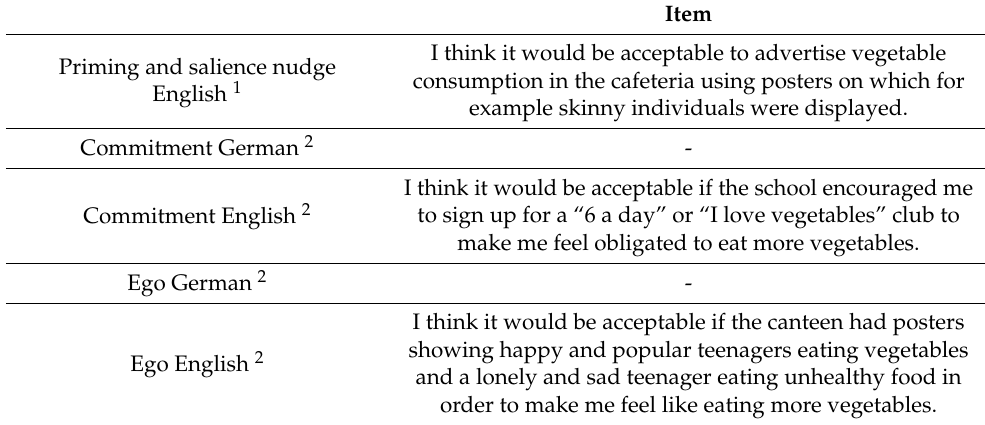
Table A2. German and English items measuring social norms [36].